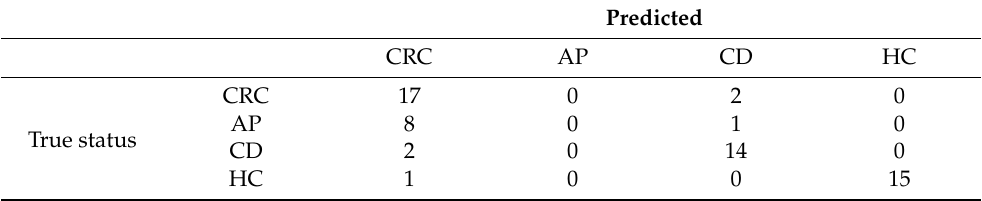
Table 4. Classification results of the PLS-DA model. PLS-DA = partial least squares discriminant analysis; HC = healthy controls; CD = celiac disease; AP = adenomatous polyposis; CRC = colorec- tal cancer.